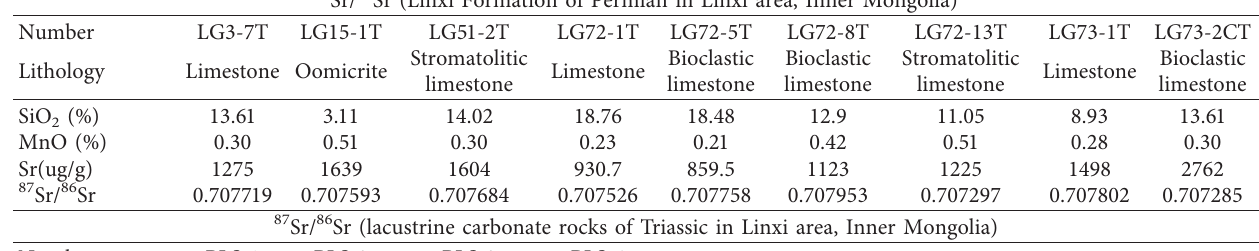
Table 2: Sr isotope values of the limestone from the Linxi area Guandi profile and compared with other parts of the world. 87 Sr/ 86 Sr (Linxi Formation of Permian in Linxi area, Inner Mongolia)